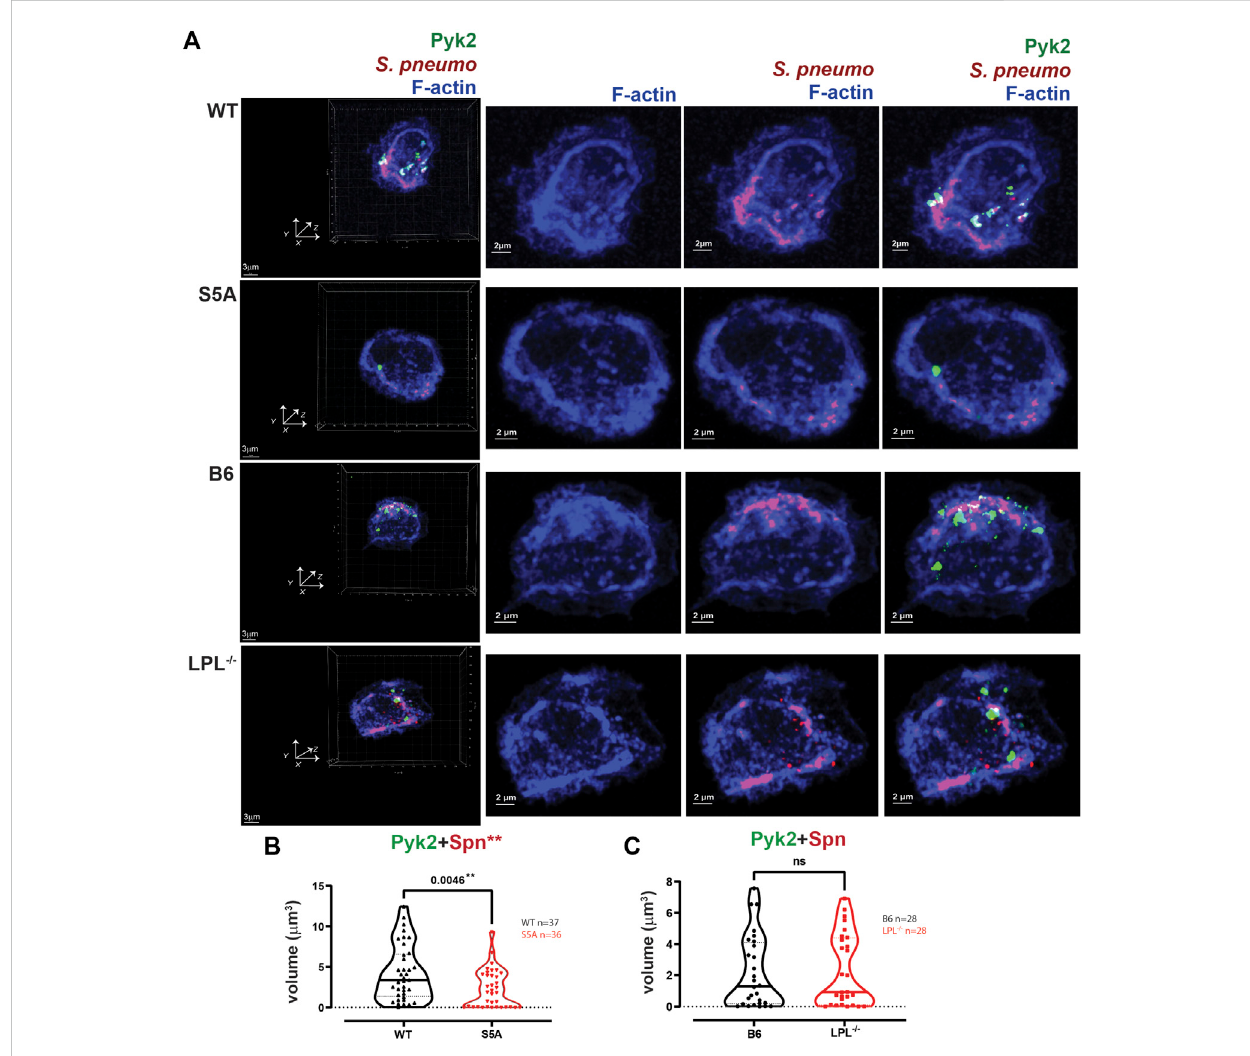
FIGURE 11 Quanti fi cation of volumes of protein aggregates reveals loss of Pyk2 from phagosomes in AMs expressing S5A-LPL. (A) Co-localization of Pyk2 (green), S. pneumoniae (red) and F-actin (blue) in AMs incubated with Spn-RFP for 60 min from matched WT and S5A or matched B6 and LPL − / − mice. Images in left panels show 3D reconstruction of Z-stack confocal micrographs. Other panels are 2D XY projections showing F-actin only, Spn overlaid with F-actin, or overlay of Pyk2+Spn + F-actin. Phagosomes incorporate F-actin, Spn and Pyk2 (white; representative phagosomes indicated by white arrows). Grids show 2 μ m increments and are optimal for size assessment; scale bars in subsequent panels are derived from grids. (B, C) . Total volumes ofaggregates of Pyk2+Spn from WT and S5Asamples (B) orB6and LPL − / − samples (C) . Each symbol represents thevolume calculated from one fi xed cell; n = number of cells analyzed. Images acquired from two independent experiments. p -values determined by Mann-Whitney; ns = non- signi fi cant; ** p <